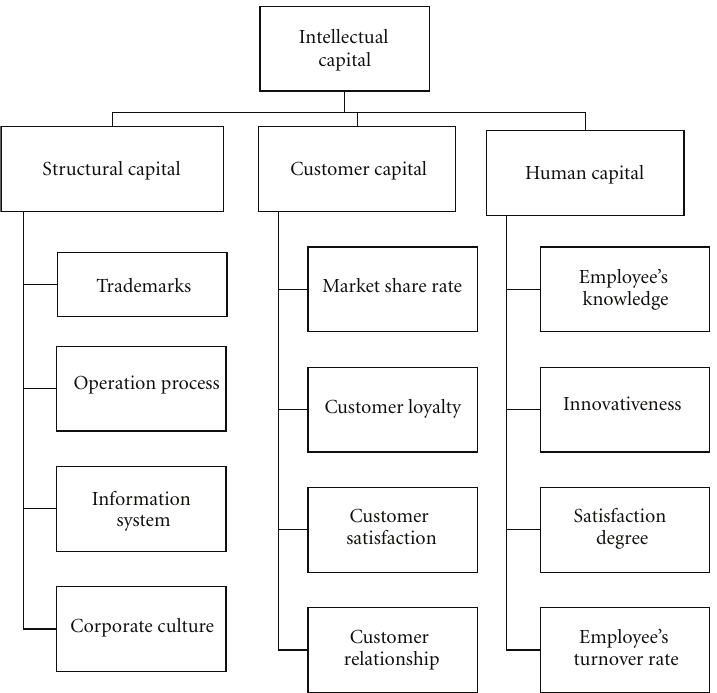
Figure 4: Components of intellectual capital (revised from